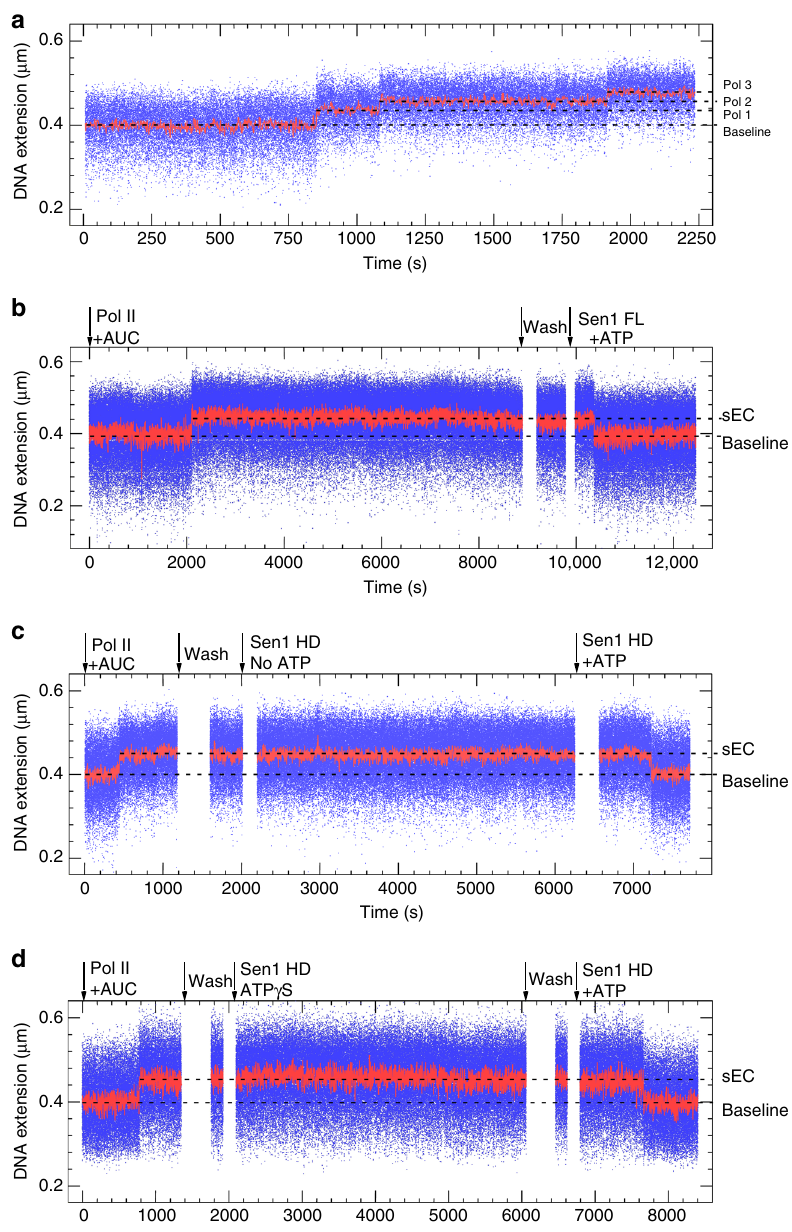
Fig. 2 ATP-dependent removal of stalled Pol II by Sen1. a Time-trace showing successive extension increases as Pol II molecules accumulate on the DNA without terminating. b Time-trace showing a single Pol II can be removed by full-length Sen1 in the presence of ATP. Black arrows indicate moment of addition of indicated component. For the sake of clarity, DNA extension during additions is not shown. c Time-trace showing Pol II removal by Sen1 HD does not take place in the absence of ATP, but takes place in the presence of ATP. d Time-trace showing Sen1 HD does not remove stalled Pol II if